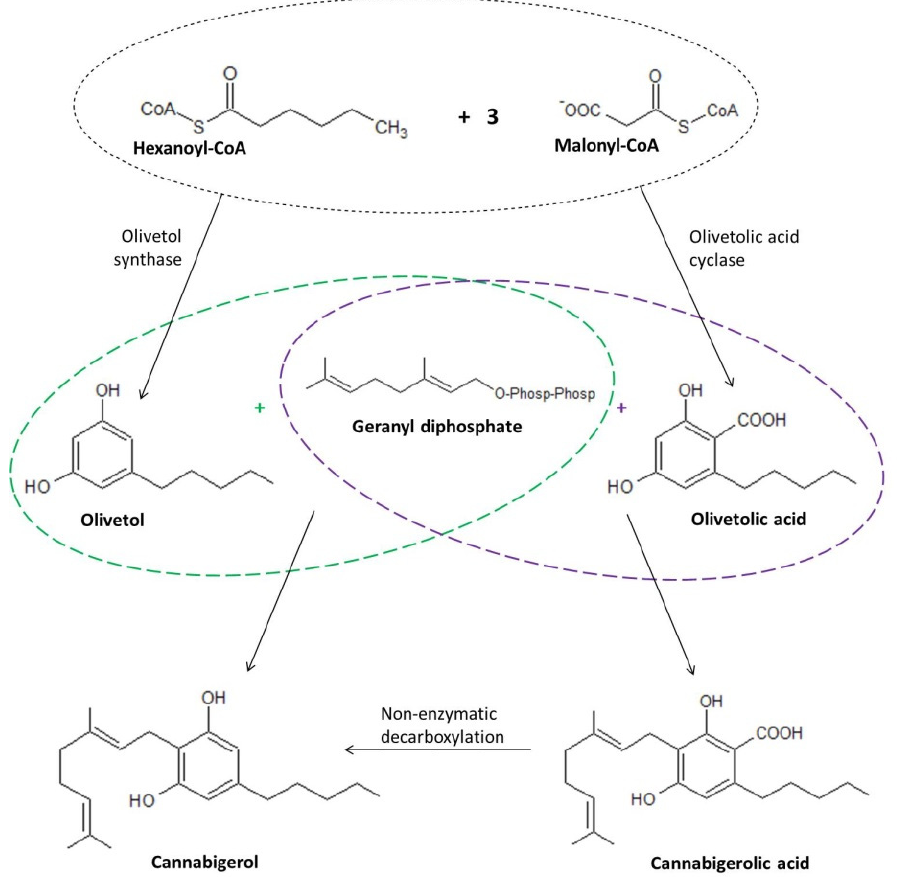
Figure 3. Biosynthesis of CBG including both direct synthesis and the formation of cannabigerol by non-enzymatic decarboxylation of cannabigerolic acid [30,31]. Taking into account the details concerning cannabigerol biosynthesis, it was found that glucose produced through photosynthesis is converted to phosphoenolpyruvate, which—under the influence of pyruvate kinase and pyruvate dehydrogenase—is converted to acetyl-coenzyme A (acetyl-CoA) (Figure 4A). Acetyl-CoA is a key chemical that acts as a substrate in the formation of both geranyl diphosphate and malonyl-CoA, which are neces- sary for the formation of olivetolic acid and olivetol, i.e., the precursors of cannabigerolic acid [32] and cannabigerol, respectively [31]. Hexanoyl-CoA, on the other hand, is formed during the action of hexanoyl-CoA synthase on hexanoic acid formed in the process of biosynthesis of fatty acid [33]. The aldol condensation of hexanoyl-CoA and malonyl-CoA (ratio 1:3) in the presence of olivetolic acid cyclase (OLAC) results in the formation of olive- tolic acid [32], whereas in the presence of olivetol synthase (OLS), decarboxylation with simultaneous cyclization results in the formation of olivetol [31]. As a result of numerous transformations, Acetyl-CoA is initially converted to mevalonic acid (MVA), which is then converted to geranyl diphosphate under the influence of kinases, decarboxylases, and isomerases